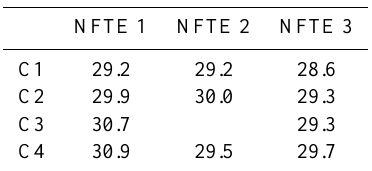
Table 1. X-line locations ( R E in the tail) for separate NFTEs ob- tained by the incompressible variant of the method (Semenov et al., 2005).